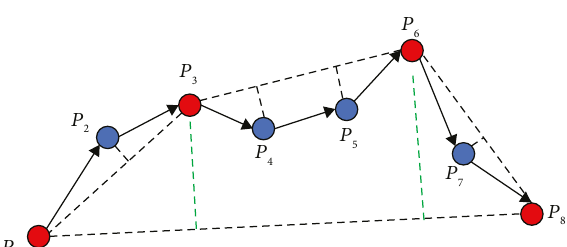
Figure 2: Illustration of the Douglas–Peucker (DP) algorithm.